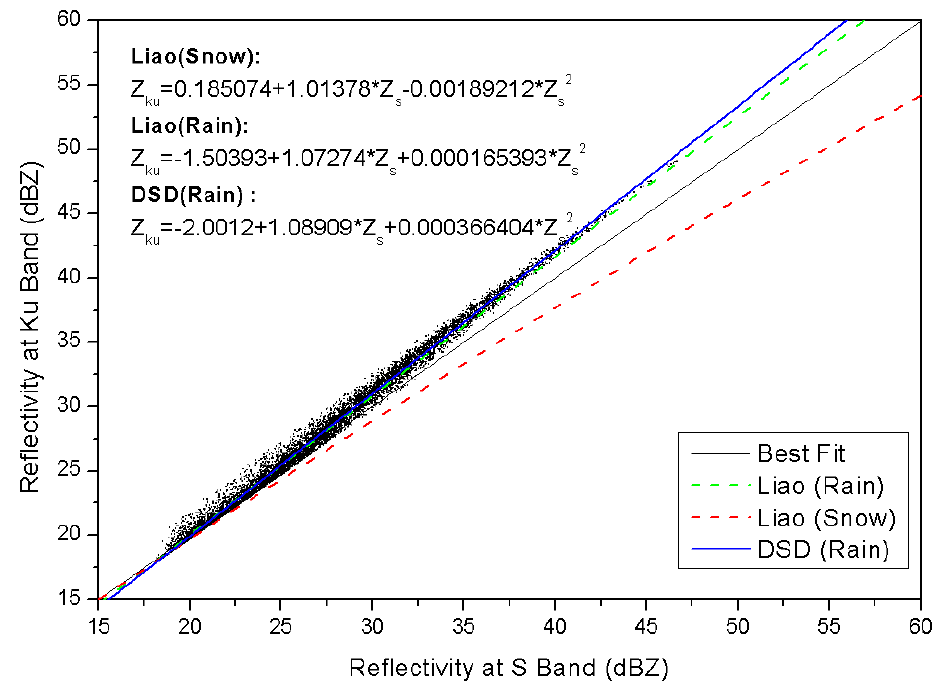
Figure 3. Reflectivity relations between Ku and S band. Liao(Rain) and Liao(Snow) curves are from Liao and Meneghini [39]. DSD(Rain) curve is from DSD calculation.